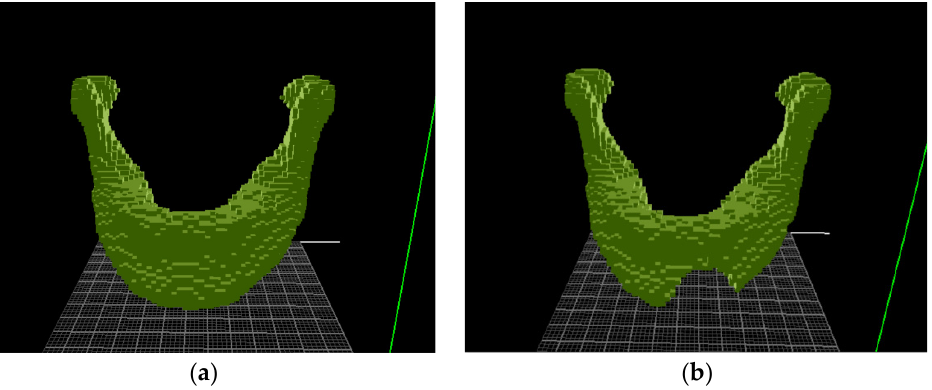
Figure 3. Example of generating random defects. ( a ) Complete mandible. ( b ) Mandible after generating defect.